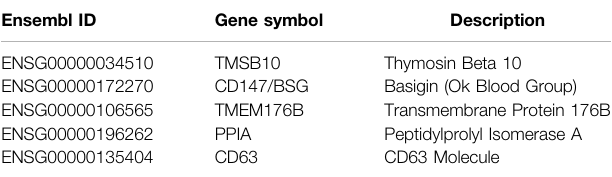
TABLE 3 | Important genes yielded by Boruta and mRMR